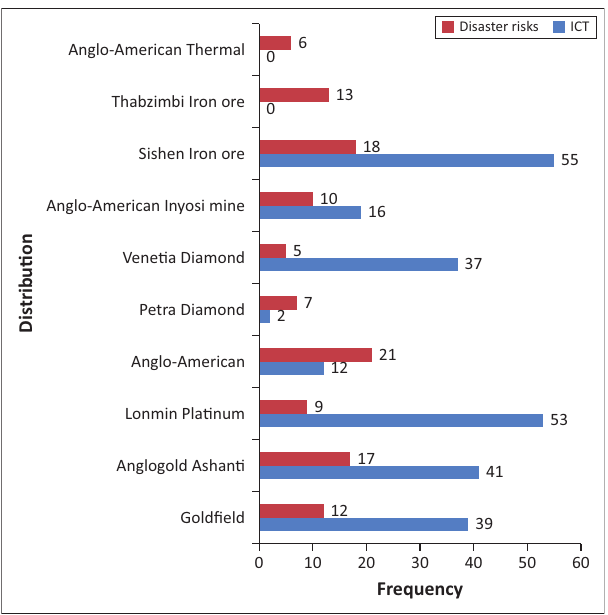
FIGURE 2: Distribution of mention of information and communication technology and disaster risks in documents analysed.